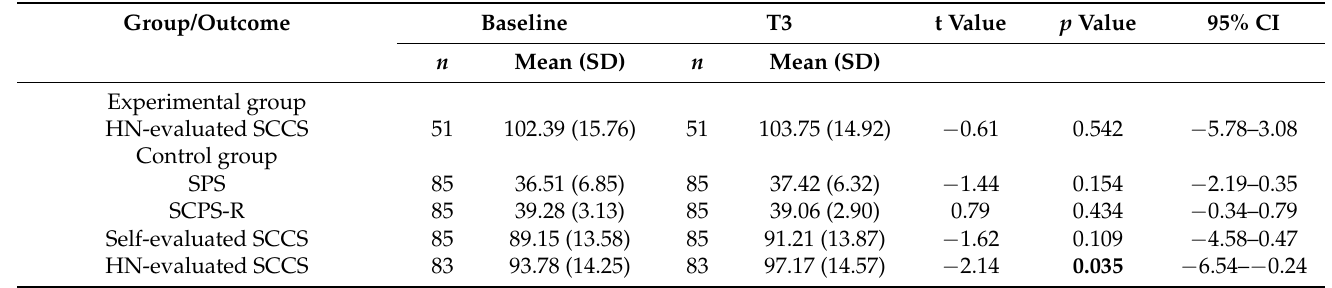
Table A4. Within-subject effects of experimental and control group at three months (Time 3) on outcomes using paired t tests.